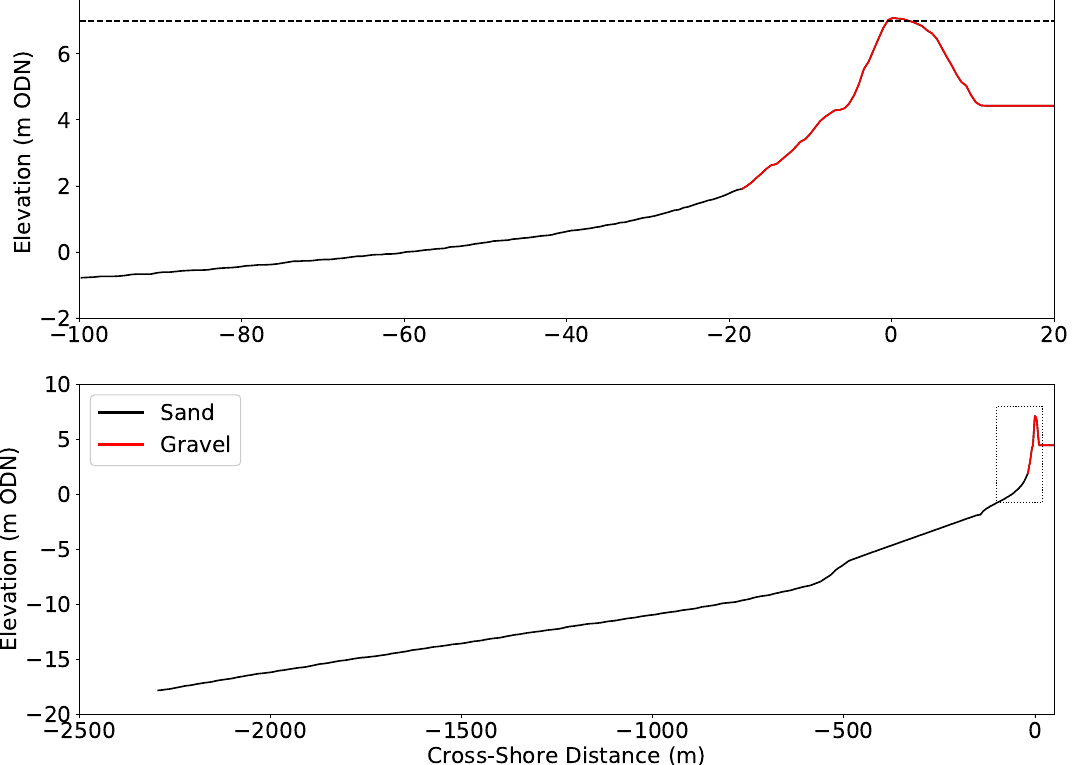
Figure 5. Applied cross-shore profile used in XBeach-X with the intertidal sandy foreshore and gravel barrier components of the composite gravel beach. The upper panel provides additional detail in the nearshore, and the dashed line at 7mODN represents the elevation above which the barrier width is artifically